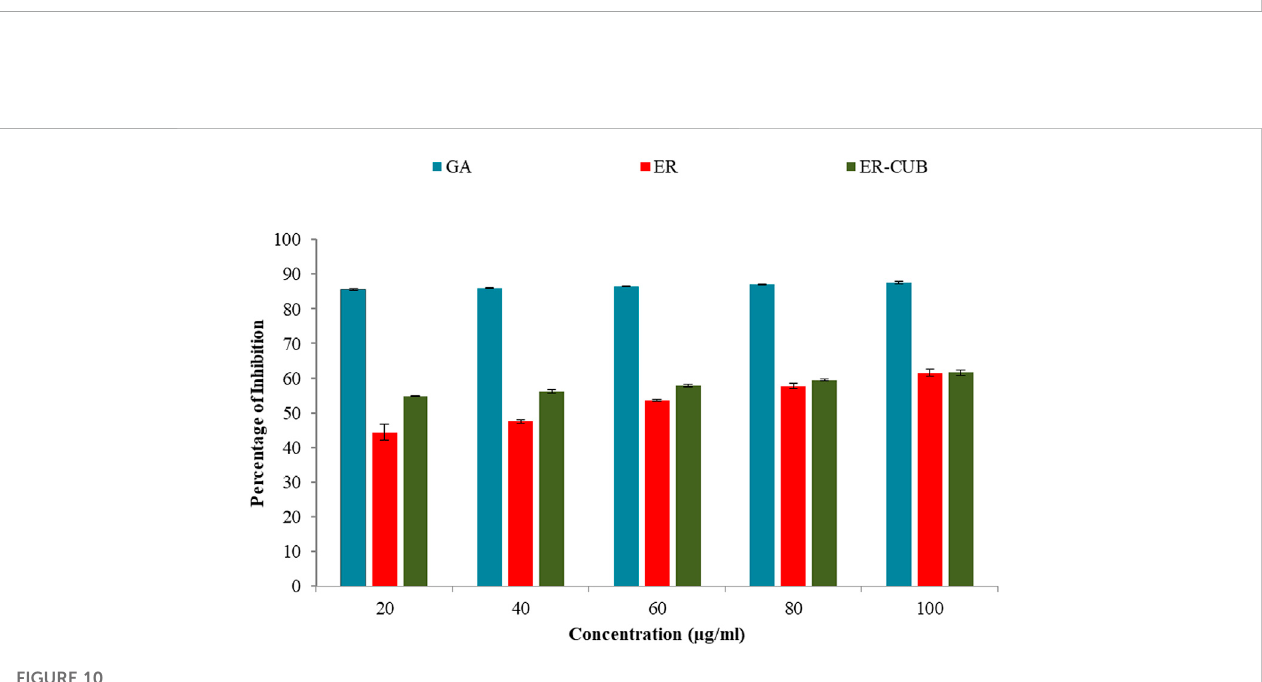
FIGURE 9 Total antioxidant capacity (TAC) of (A) ER-CUB and (B) ER (Pure) were determined using plasmid DNA on the protection of supercoiled pBR322 DNA against hydroxyl radical generated by Fenton ’ s reagent. CN, Negative control (pBR322 DNA + distilled water); FR, Positive control (pBR322 DNA + FR); Rutin, pBR322 DNA + FR + 100 µg/ml rutin; Conc. pBR322 DNA + FR + 1, 2, 4, 8, 16µg/ml